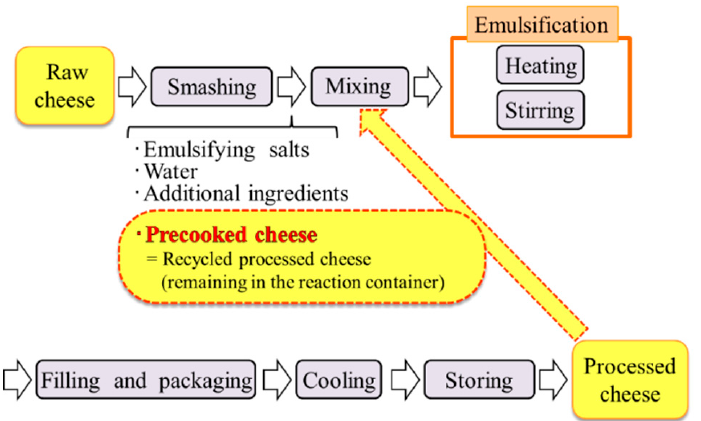
Processes 2020 , 8 , x FOR PEER REVIEW